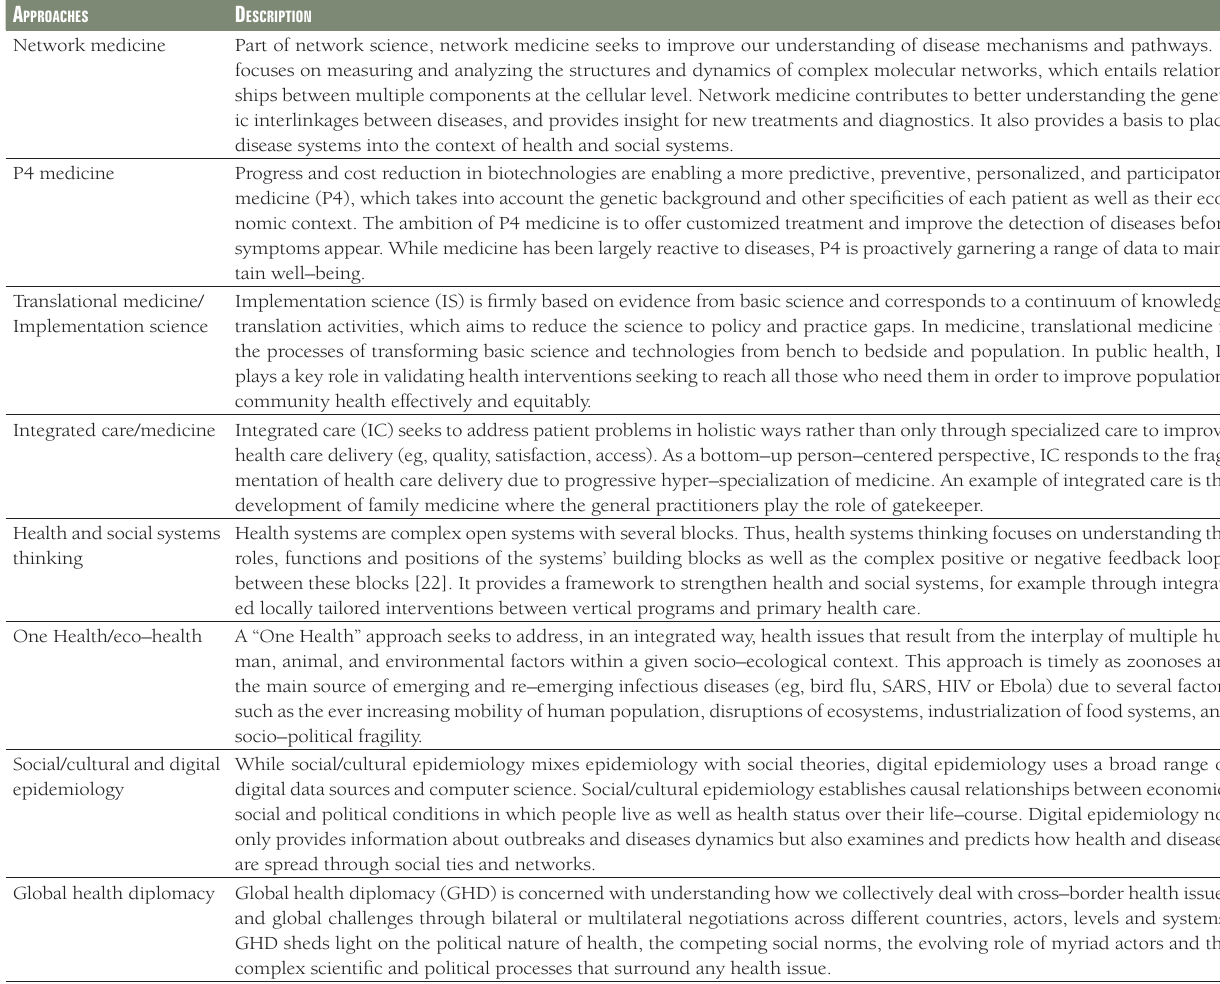
Table 2. Selected interdisciplinary research and education approaches relevant to global